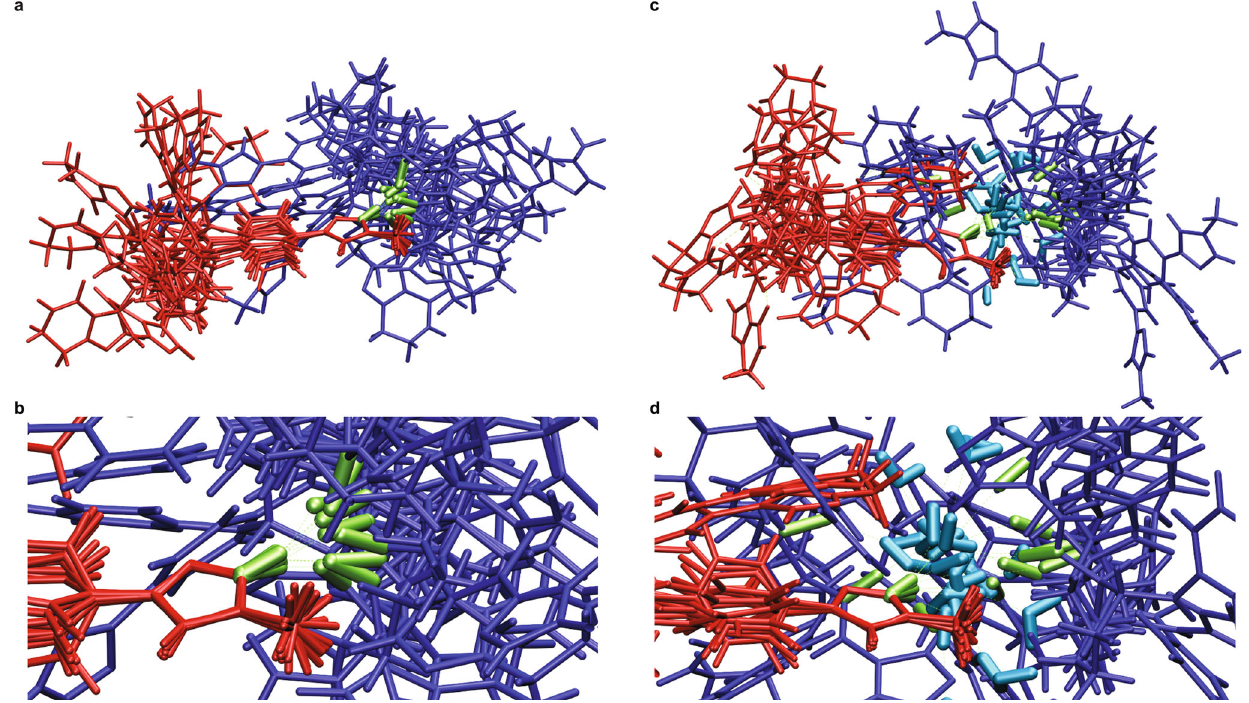
Fig. 5 Complete structures and H-bonding motifs. a Superposition of 10 instances of the N6-H···O20 bonding motif. b close-up view of the hydrogen bonding region in ( a ). c Superposition of 10 instances of the N6-H···OH 2 ···OH 2 /O20 bonding motif. d close-up view of the hydrogen bonding region in ( c ). The red molecule represents 1 bearing the hydrogen bond donor (N6-H), the dark blue molecule represents 1 bearing the hydrogen bond acceptor, water molecules are coloured in cyan and the atoms of 1 involved in the hydrogen bonding motif are coloured in